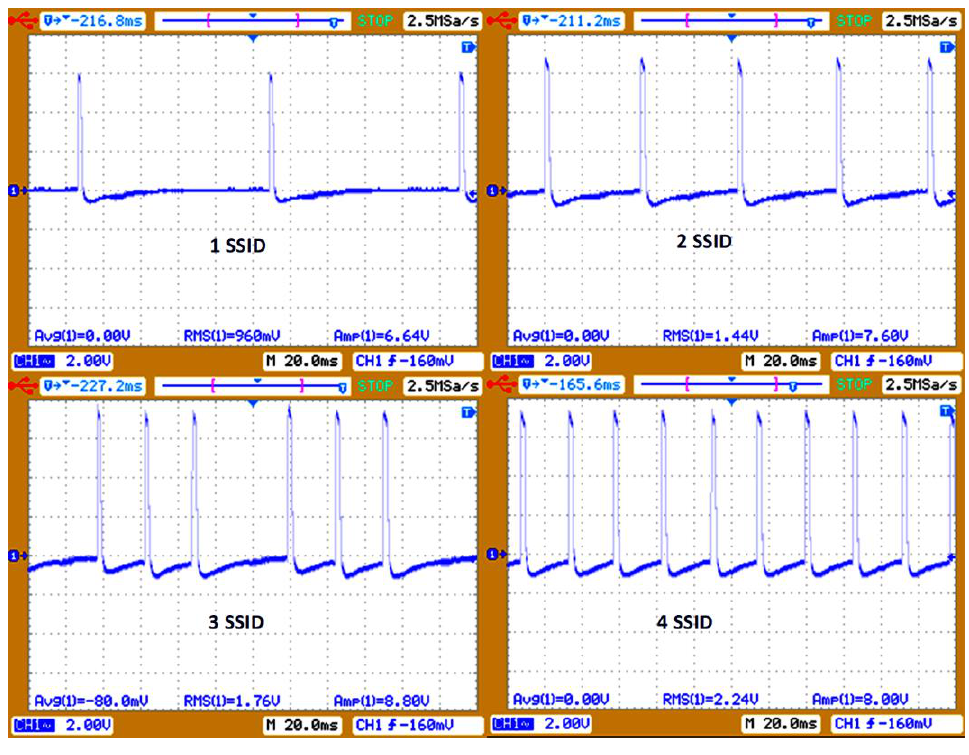
Figure 5. Exposed harvester output WiFi signal with 1 and 2 SSID without traffic.